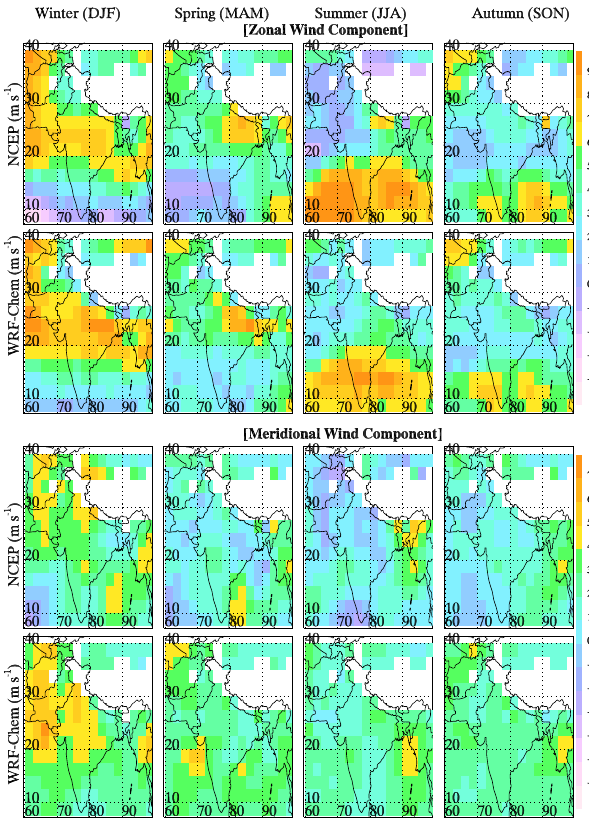
Fig. 7. Spatial distribution of co-located NCEP and the model sim- ulated average zonal (first and second rows) and meridional (third and fourth rows) wind components at 700hPa during the winter, spring, summer and autumn seasons of the year 2008. The white space indicates missing data in NCEP as well as in the